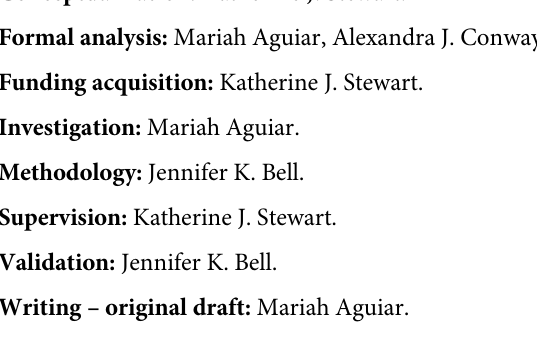
S3 Table. Results from the PERMANOVA for bacteria and fungi at Conservation Learning Centre and St. Denis National Wildlife Area. S4 Table. Estimate parameters from both final structural equation